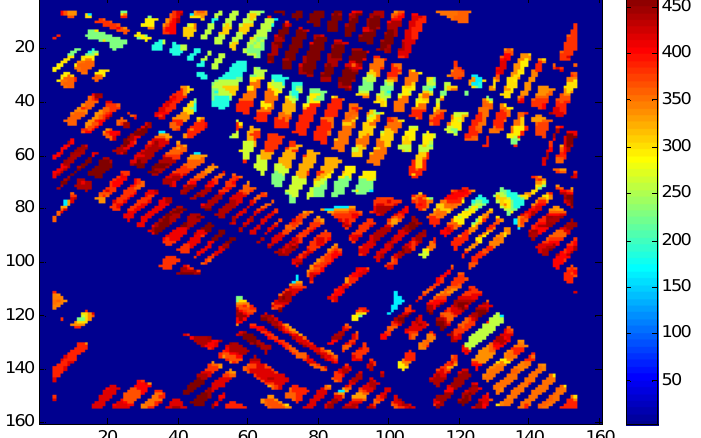
Figure 4. Map of seasonal crop water requirement ET by applying the FAO-56 dual